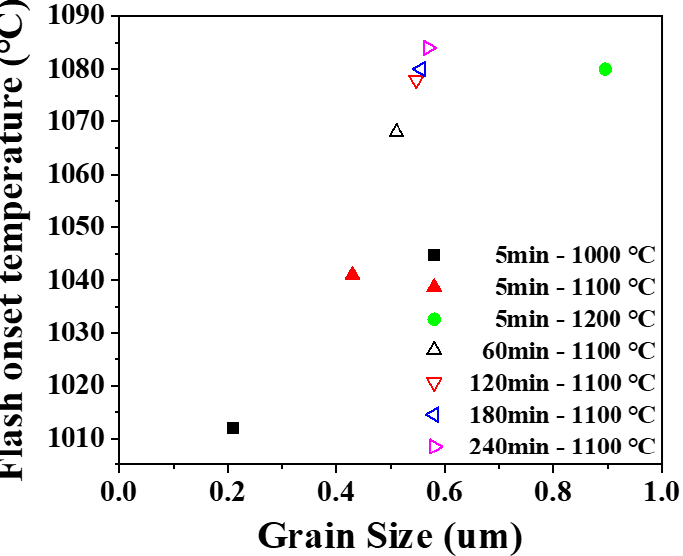
Figure 6. Change in flash onset temperature with a grain size of presintered sample. Legend shows presintering condition.